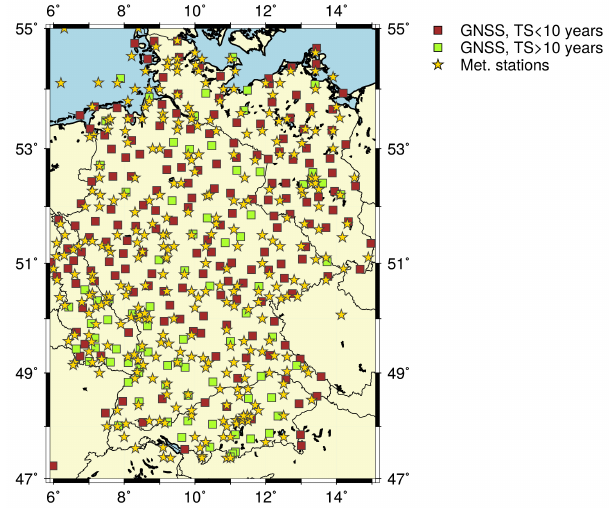
Figure 1. The location of the GNSS and meteorological sites within the research region; 119 GNSS sites of 351 have time series of 10 to 19 years